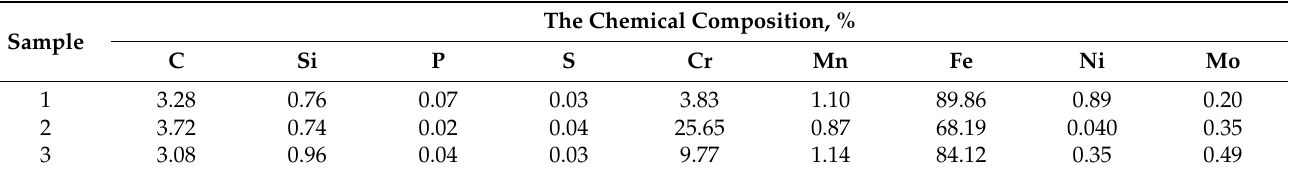
Table 1. The chemical composition of the cast iron